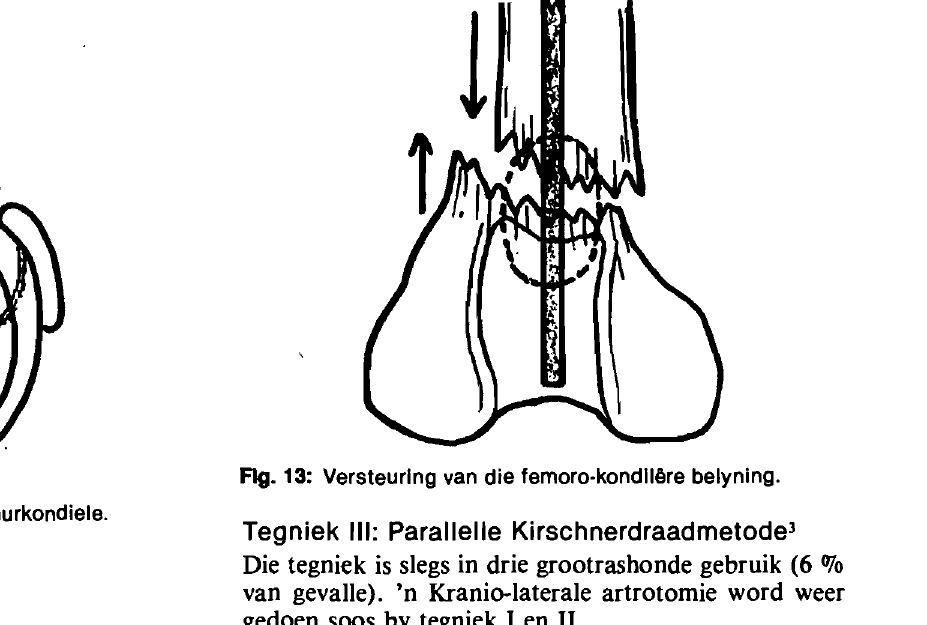
fig_ 13: Versteurlng van die femoro-kondlillre beiyning. Tegniek III: Parallelle Kirschnerdraadmetode 3 Die tegniek is slegs in drie grootrashonde gebruik (6 070 van gevalle). 'n Kranio--Iaterale artrotomie word weer gedoen soos by tegniek I en II.